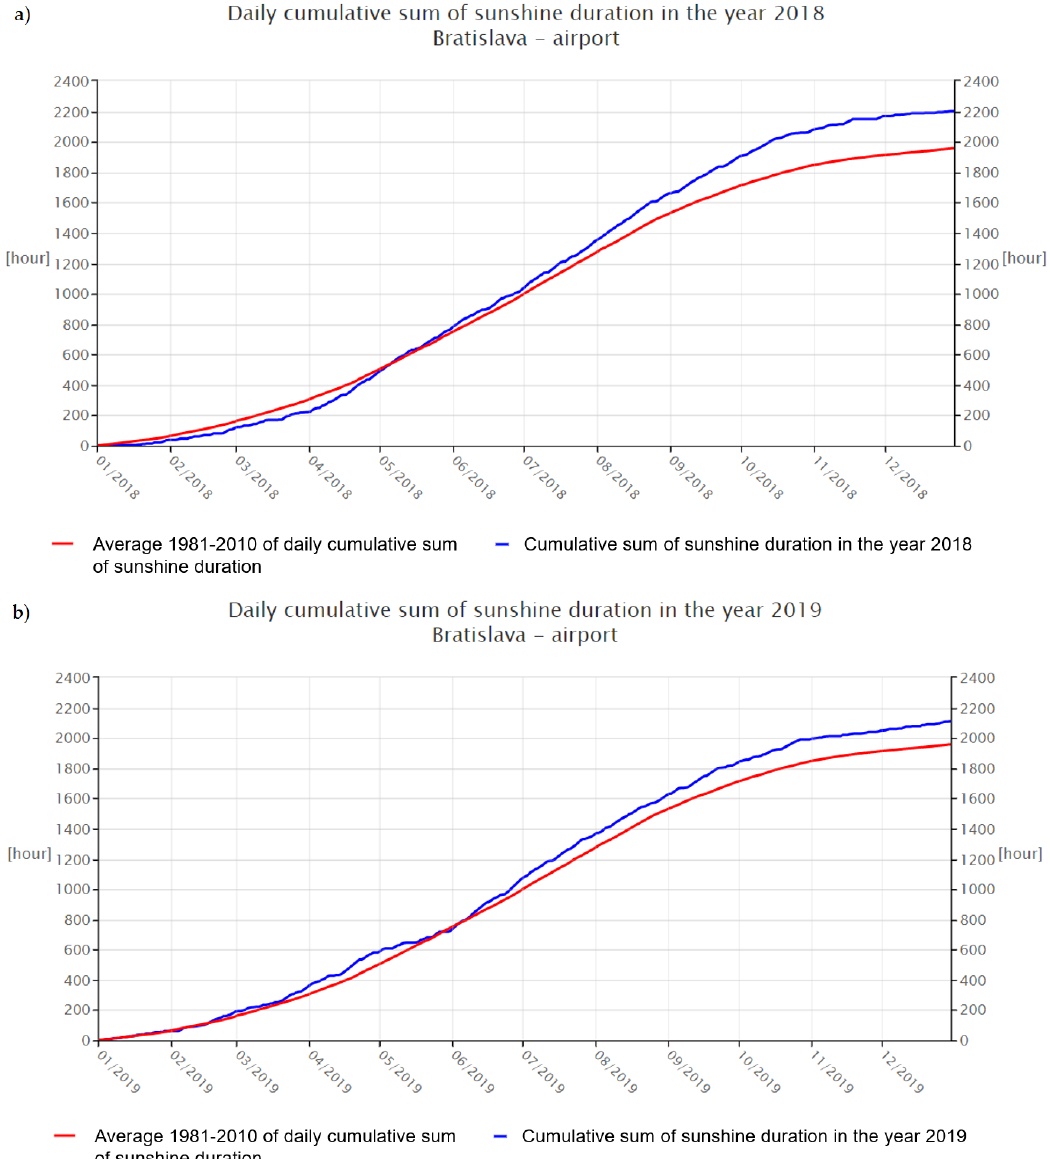
Figure 4. The graphs of sunny hours: ( a ) sunshine 2018 [26], ( b ) sunshine 2019 [27].